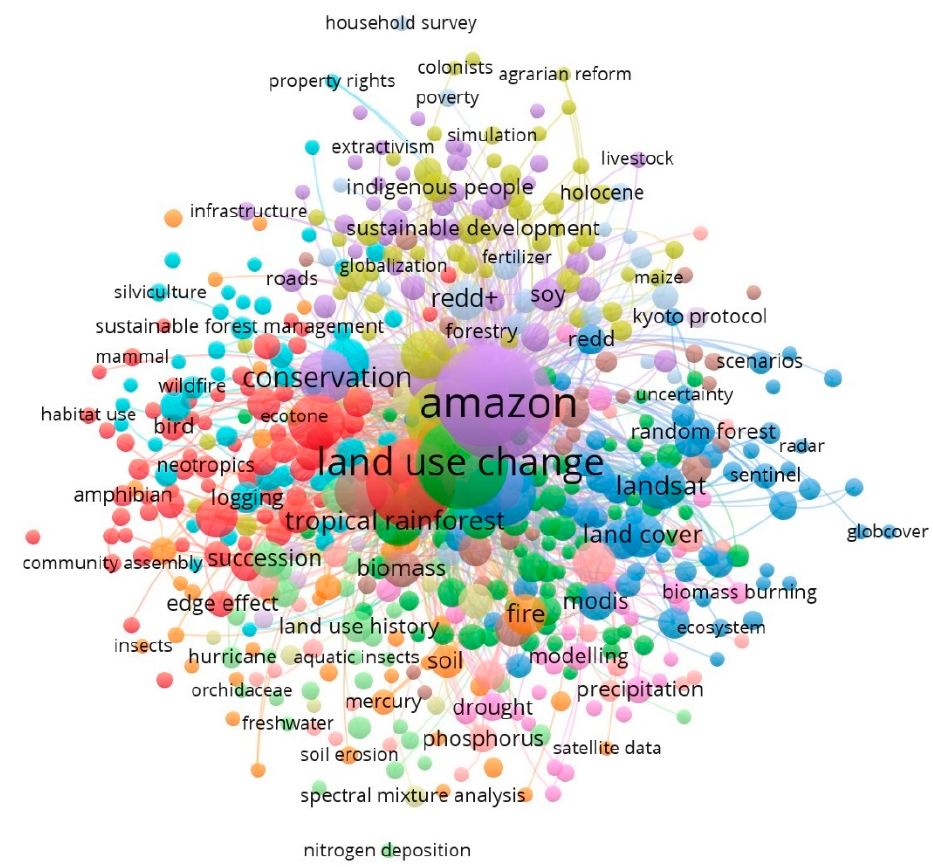
Figure 4. Visualization of themes of research (clusters of the same colour) based on the analysis of keyword co-occurrence.